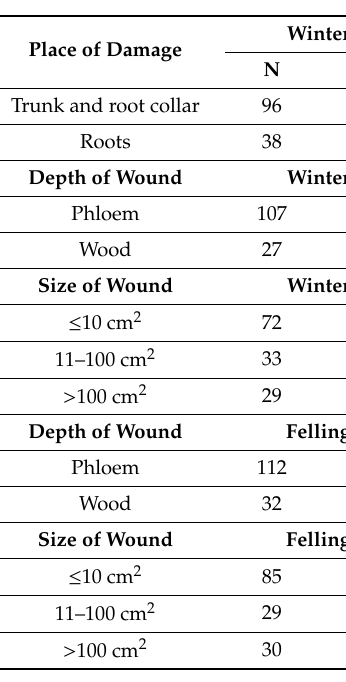
Table 2. Share of damaged trees with respect to place and depth of damage, and type of forest harvesting